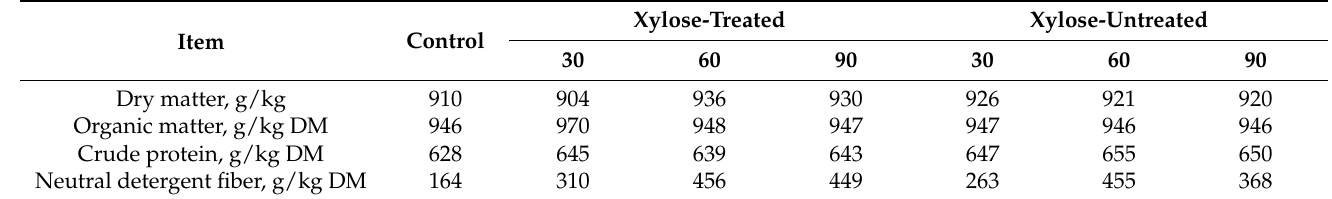
Table 2. Chemical composition of experimental ingredients for Experiment 2—Conventional Oven.